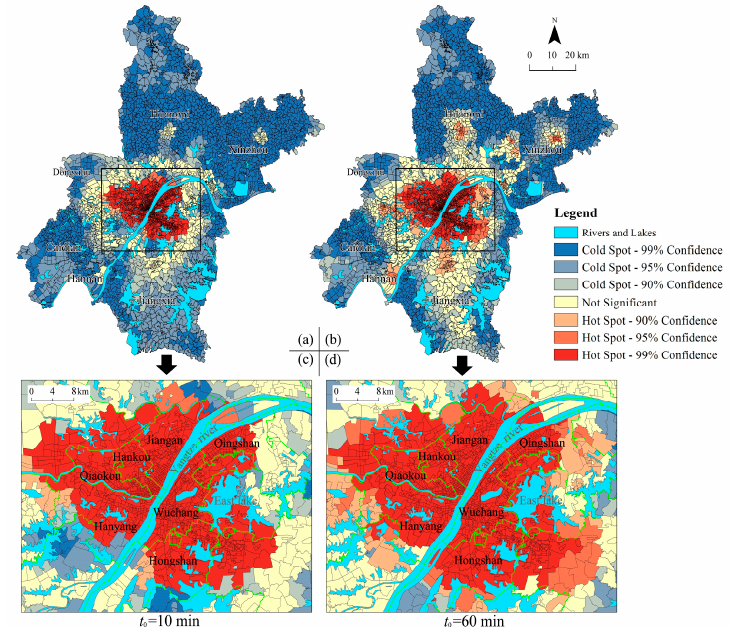
Figure 6. Hot spot Analysis of urban-rural resident autonomous units (URAUs) for Wuhan; ( a , b ) is the map in the global perspective as threshold time t 0 = 10 min and t 0 = 60 min correspondingly; ( c , d ) is the central urban area in an enlarged view with threshold time t 0 = 10 min and t 0 = 60 min correspondingly.